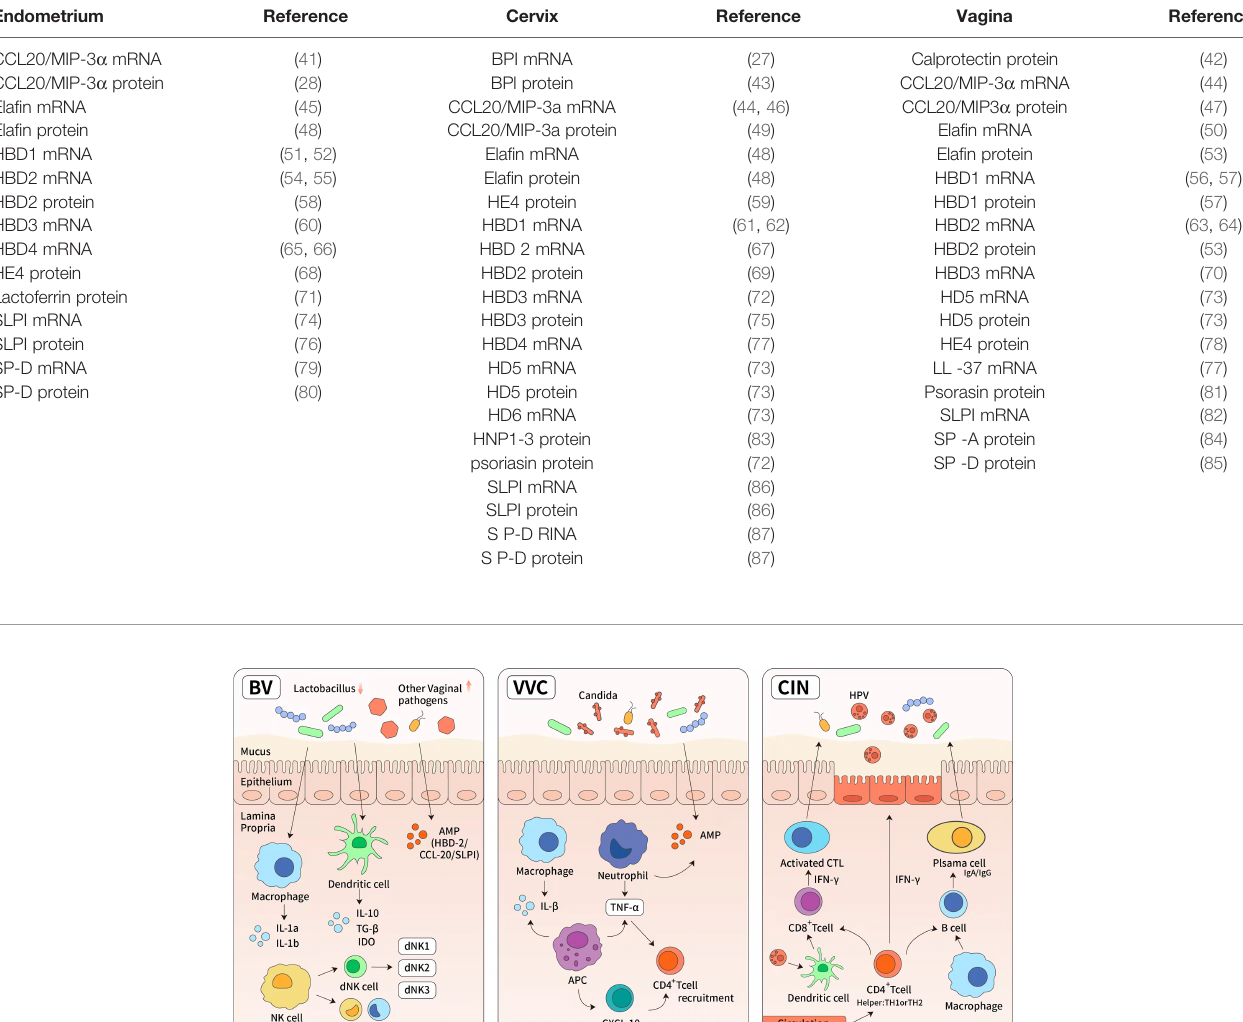
TABLE 1 | The identi fi ed antimicrobial peptides (AMP) from the mucosa of female reproductive